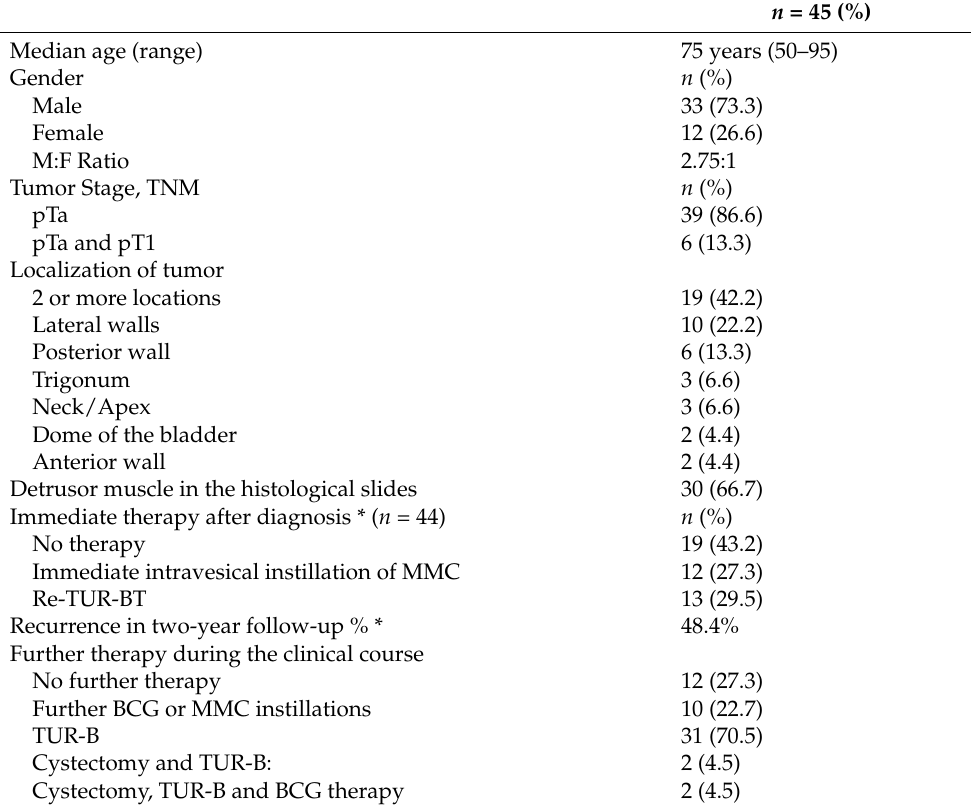
Table 1. Clinical characteristics of cases with non-invasive urothelial papillary